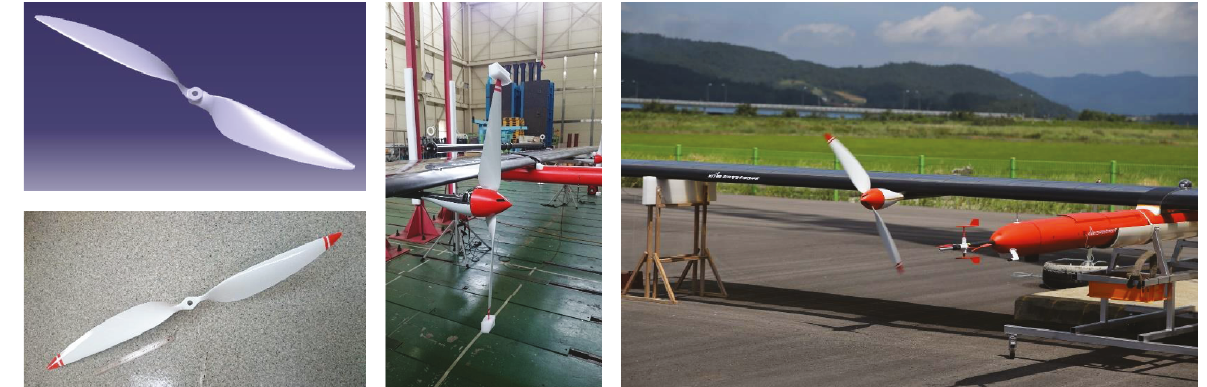
Figure 12: Manufactured and mounted propeller for